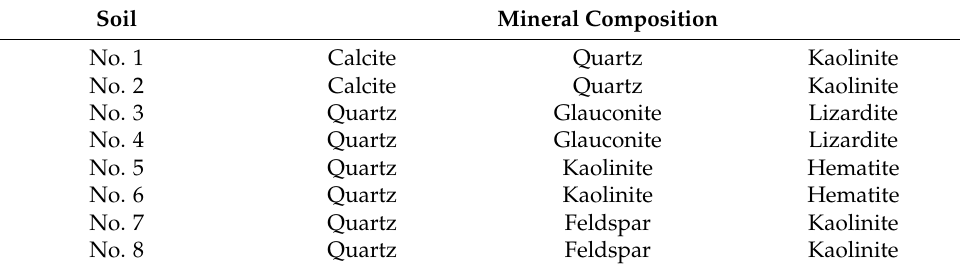
Table 2. Mineralogical composition of soils.